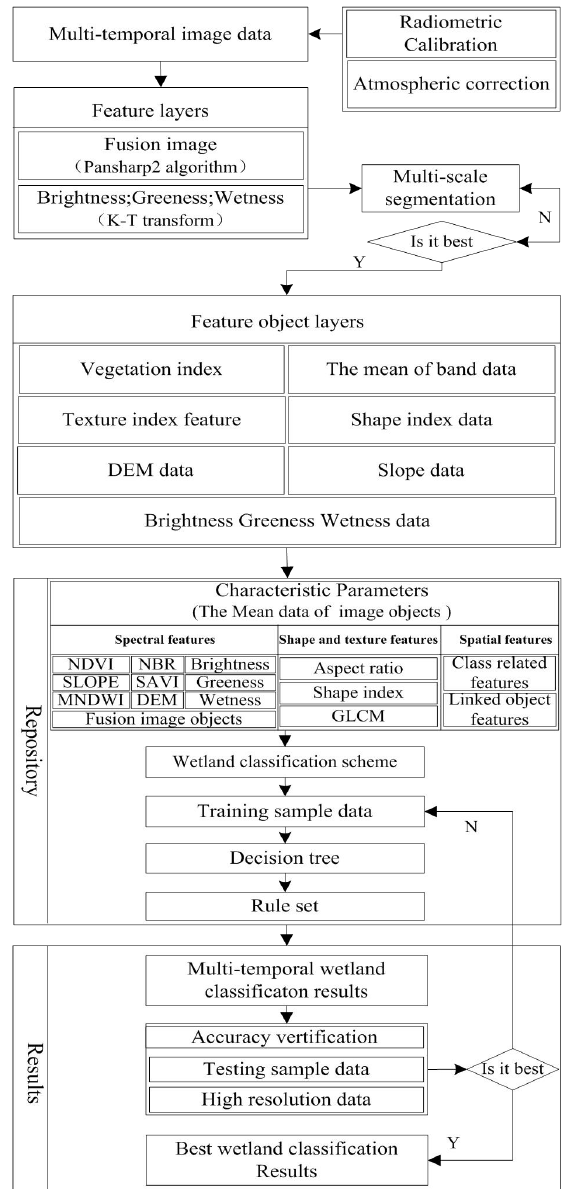
Figure 3. Technique flowchart of